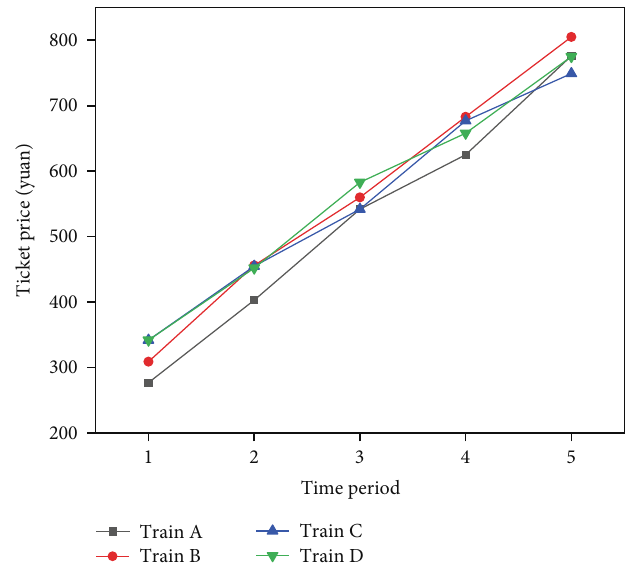
Figure 6: Ticket price for OD pair 7.